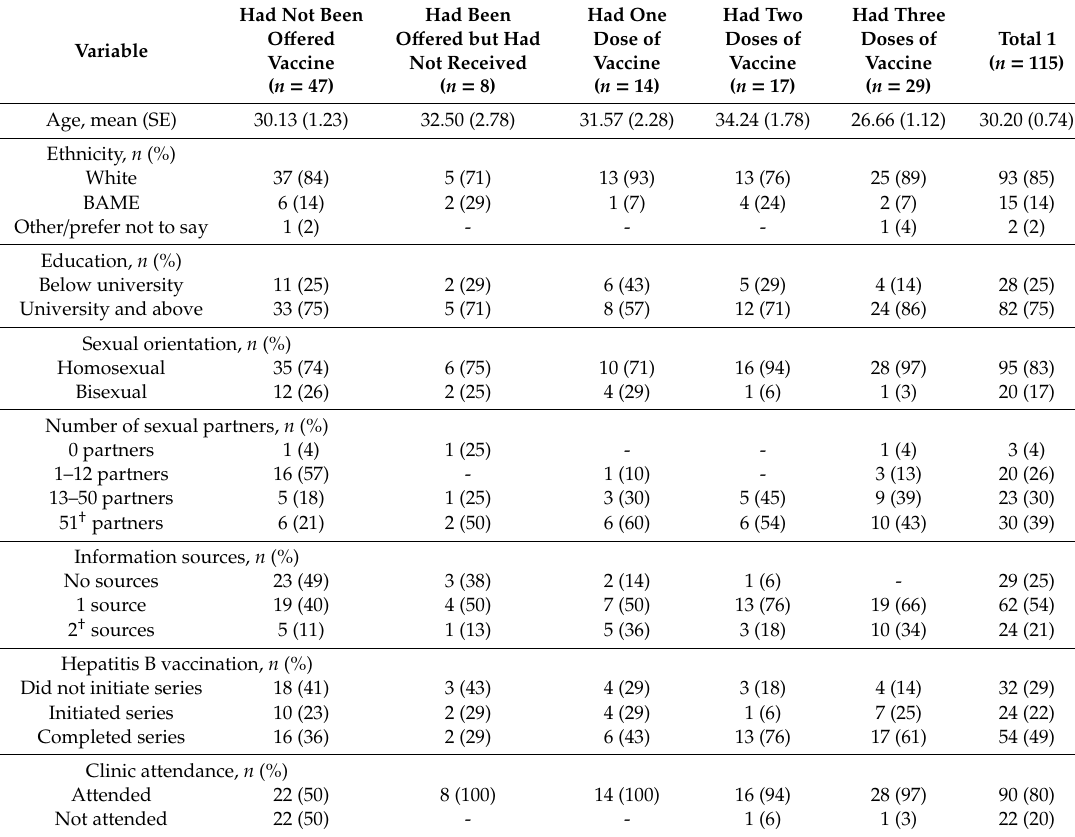
Table 1. Descriptive statistics by vaccination status. n = 115 1